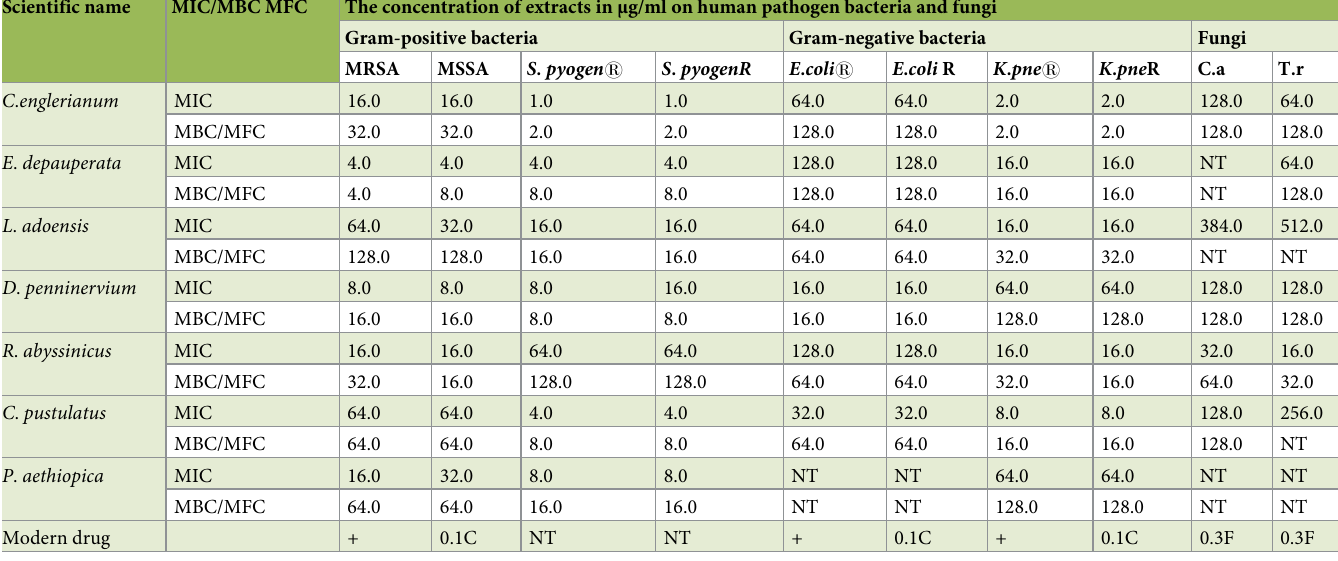
Table 2. MIC and MBC/MFC values of the methanolic extract against human pathogens on agar dilution method performed at AAU,